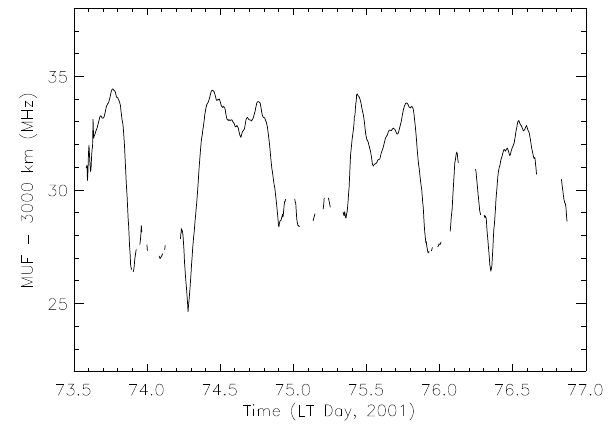
Fig. 2. Maximum usable frequency as a function of ground range over the Kodiak SuperDARN radar field-of- view obtained using ground-scatter data recorded on 23 June 2001 from 22:39– 22:55UT. For any point in the field-of- view, the color scale indicates the best- fit value of MUF for HF communica- tions between that location and the Ko- diak radar site.